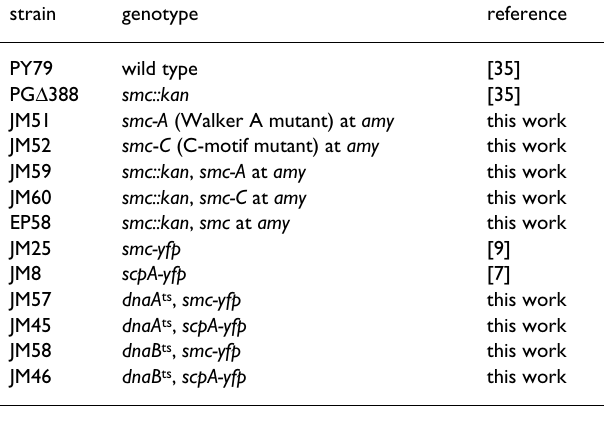
Table 1: strains used in this study strain genotype reference